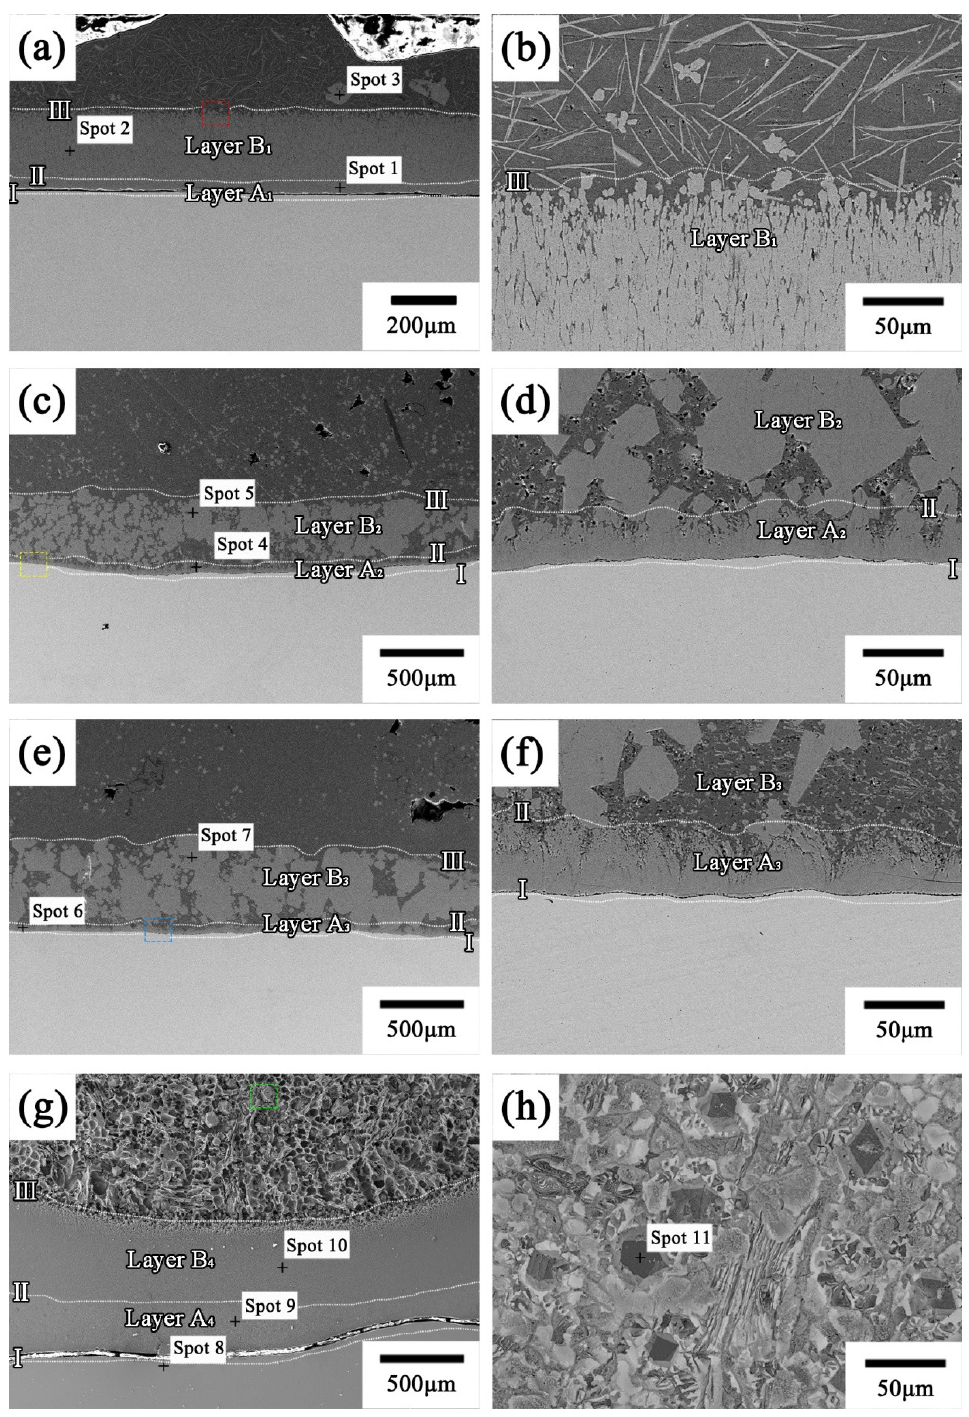
Figure 7. Cross-sectional SEM micrographs of the Co-based alloy cladding layer immersed in liquid aluminum for different times: ( a ) immersion for 4 h; ( b ) microstructure of the red square zone; ( c ) immersion for 8 h; ( d ) microstructure of the yellow square zone; ( e ) immersion for 16 h; ( f ) microstructure of the blue square zone; ( g ) immersion for 24 h; ( h ) microstructure of the green square zone.